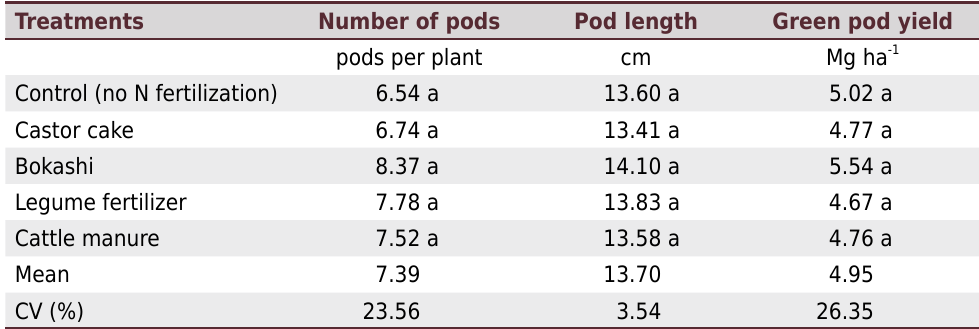
Table 2. Number of pods per plant; pod length, and green pod yield of snap bean cv. Novirex